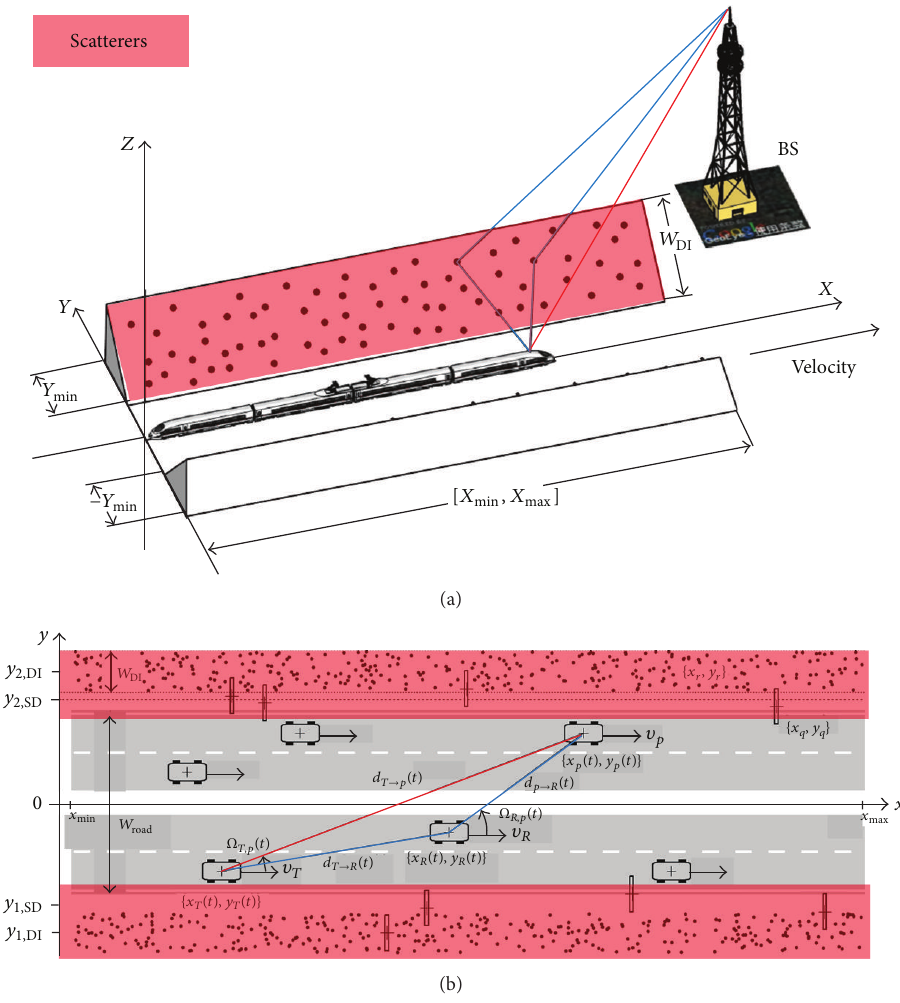
Figure 6: (a) Sketch of the geometry-based stochastic model of T2I channels in the cutting scenario with scatterers in realistic positions [36]. (b) Sketch of the geometry-based stochastic model of V2V channels